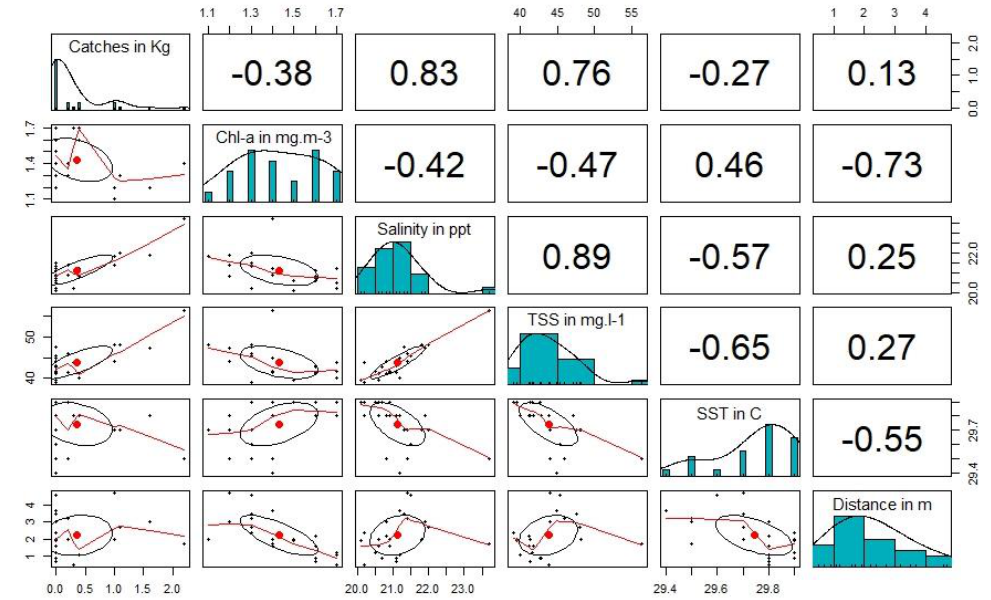
Figure 5. Correlations (R) between variables. A value that is close to ±1 has a high correlation, and vice